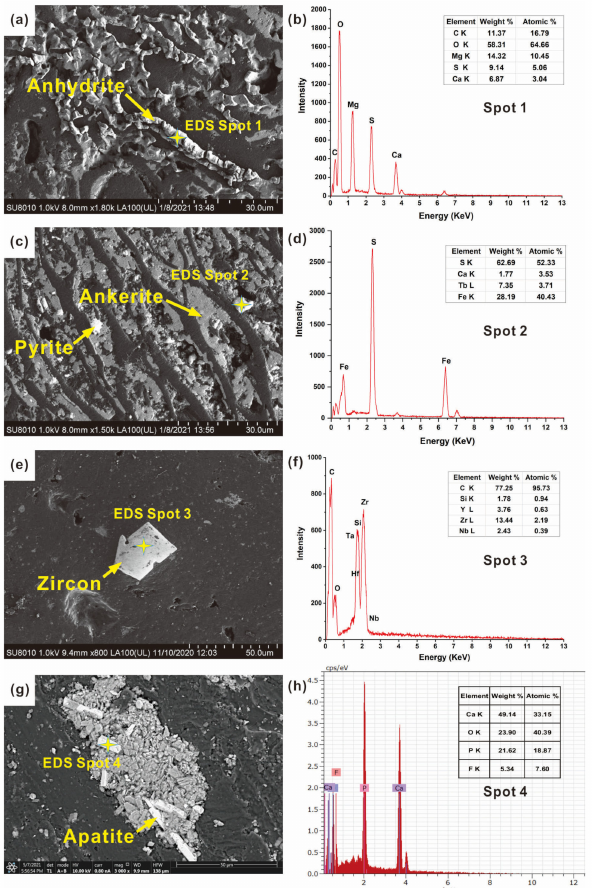
Figure 14. Mineralogical composition identified by SEM-EDS in the Tashan coal: ( a ) anhydrite in the Tashan coal; ( b ) the SEM-EDS spectra of anhydrite in (a); ( c ) ankerite and pyrite in the Tashan coal; ( d ) the SEM-EDS spectra of pyrite in (c); ( e ) zircon in the Tashan coal; ( f ) the SEM-EDS spectra of zircon in (e); ( g ) apatite in the Tashan coal; ( h ) the SEM-EDS spectra of apatite in ( g